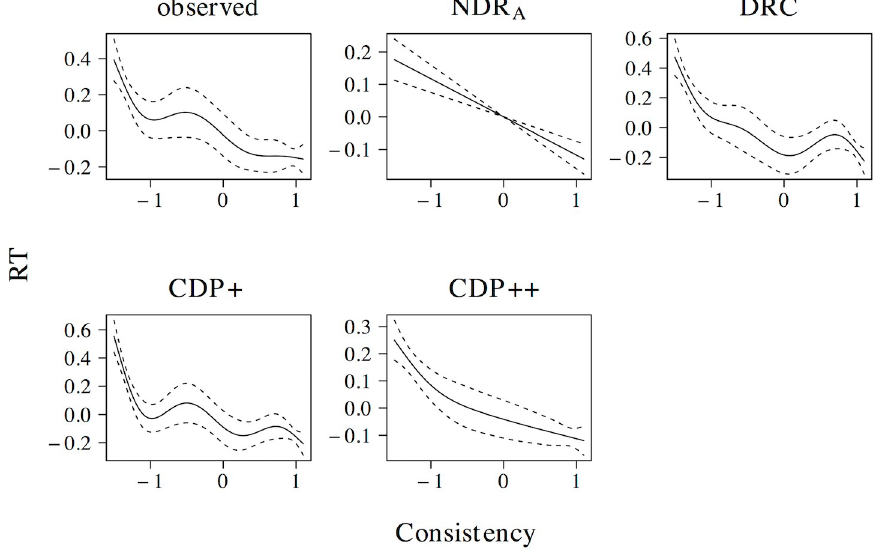
Fig 12. Consistency. The effect of consistency of the orthography to phonology mapping in word naming.